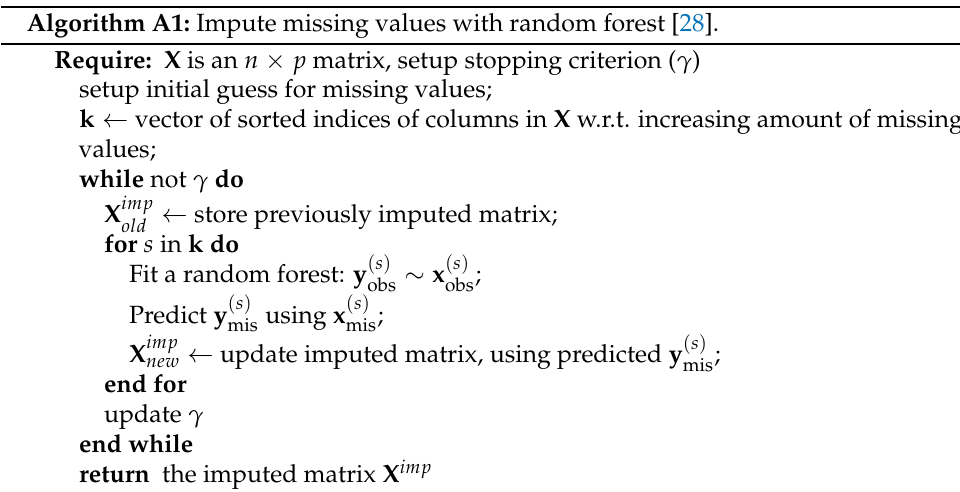
Algorithm A1: Impute missing values with random forest